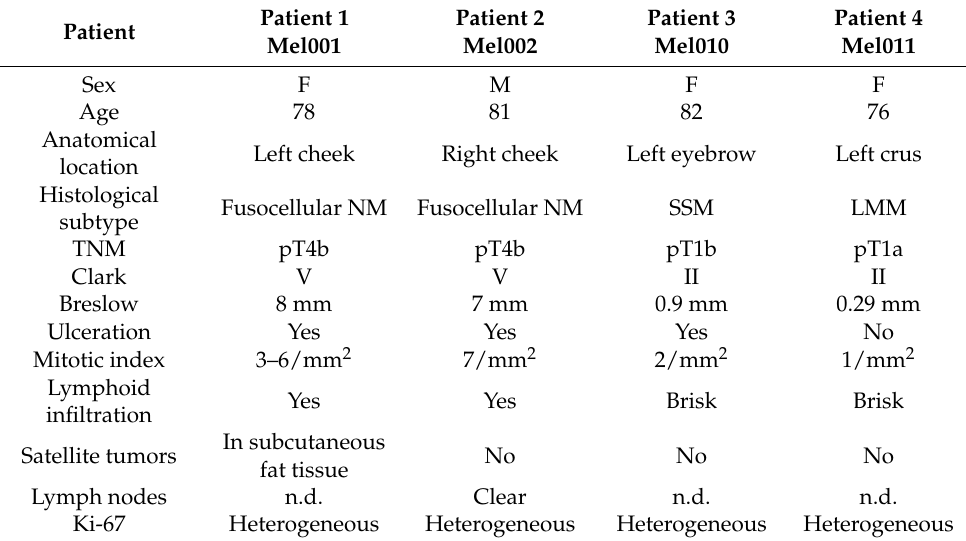
Table 1. Main clinical and histopathological data of the four patients included in the